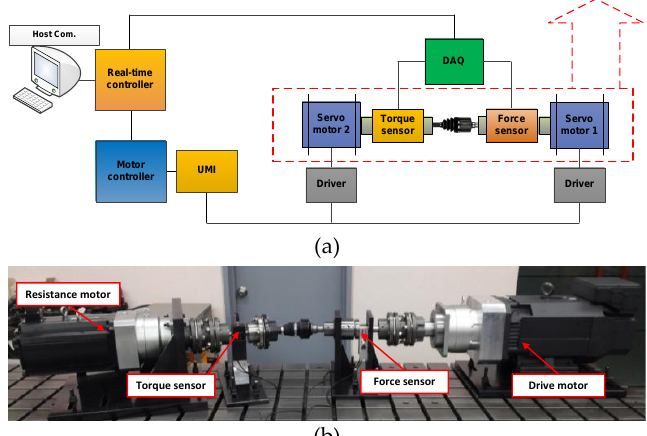
Figure 7. GAF measurement system. ( a ) schematic diagram of the system. ( b ) the actual system.